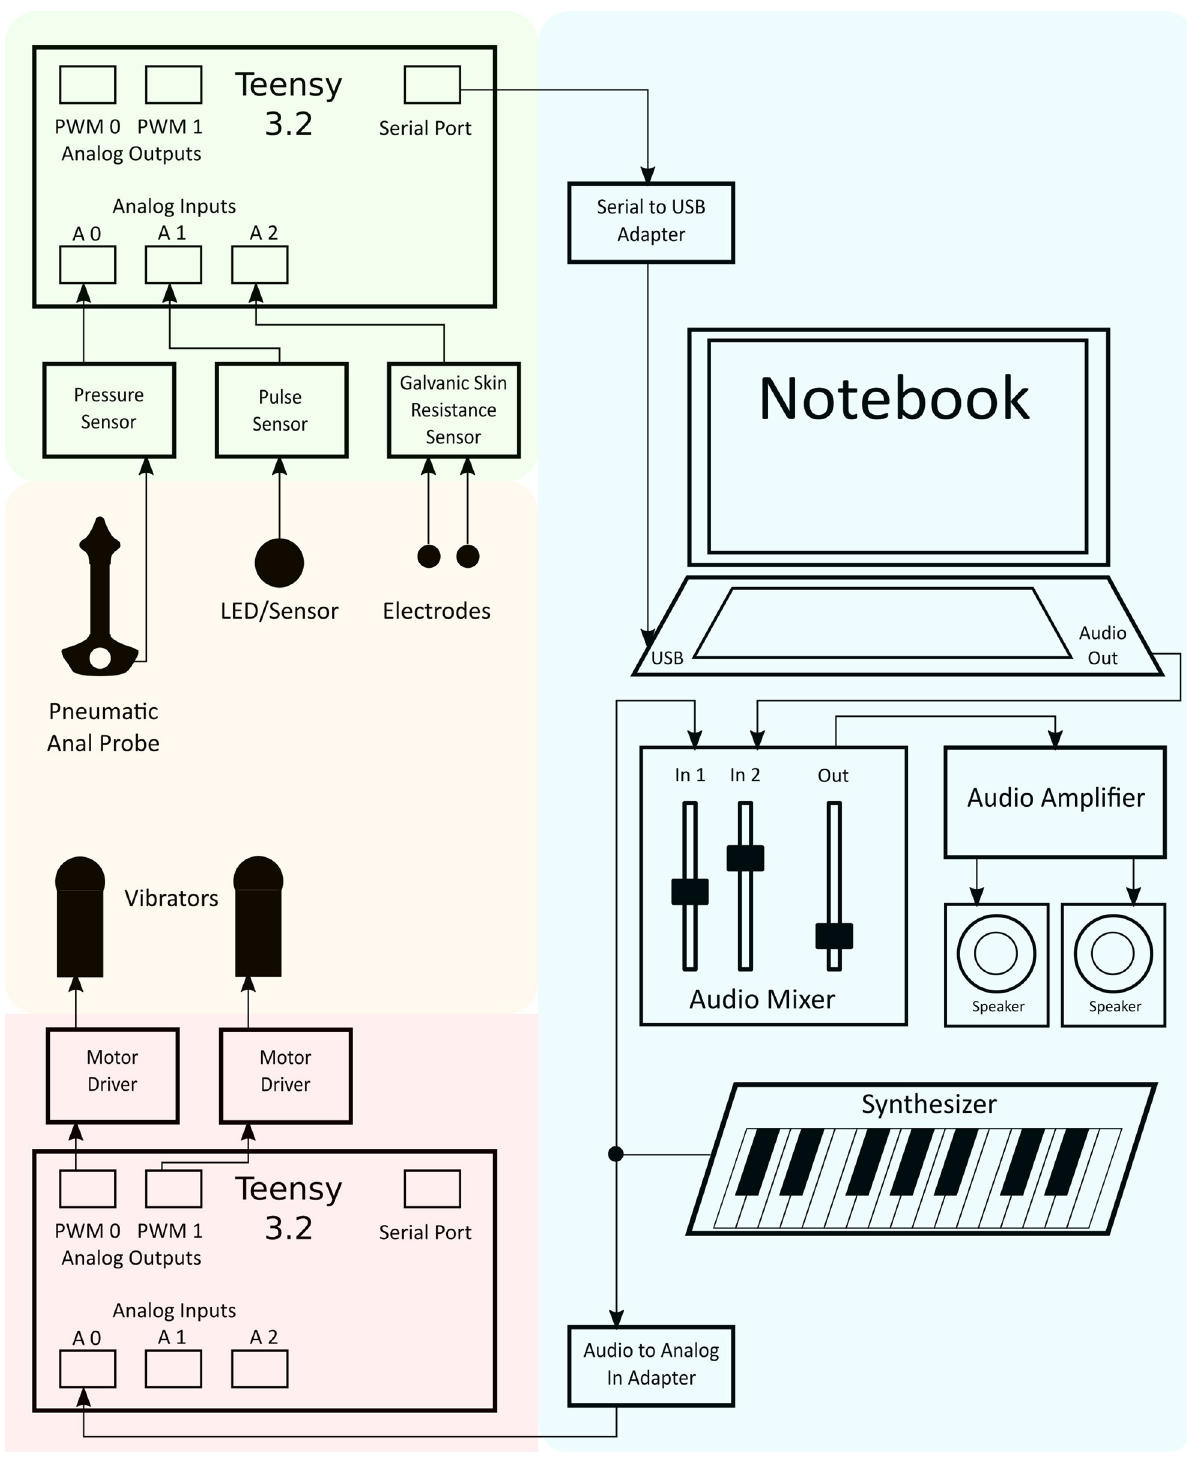
Figure 5: Connection scheme of basic